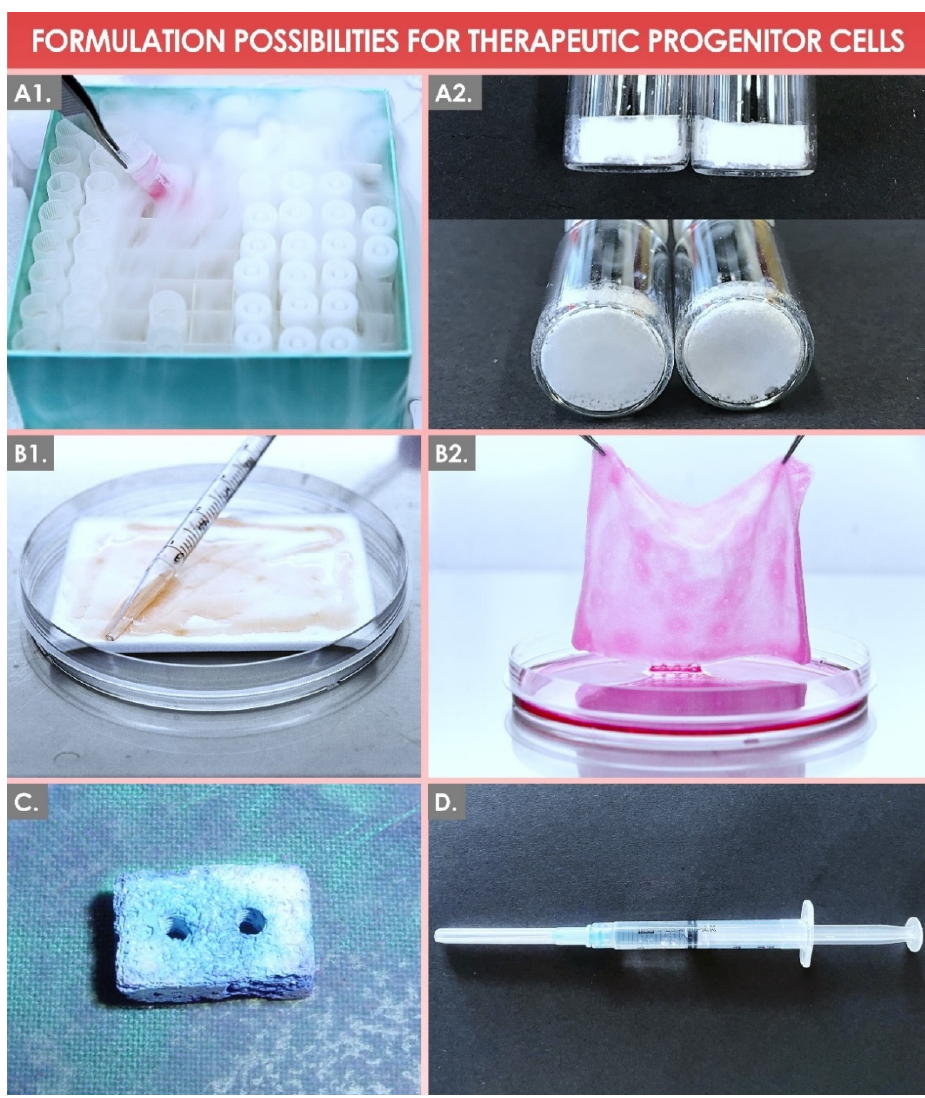
Figure 4. Graphical illustrative overview of selected formulation possibilities for therapeutic primary-progenitor cells in regenerative medicine. ( A1 ) Final form of a cellular API stored as viable cell units in liquid nitrogen. ( A2 ) Final form of a cellular API stored as devitalized cells in lyophilizate units at refrigerated temperatures. ( B1 , B2 ) Final product form of a PBB early-wound-coverage solution, composed of viable dermal progenitor fibroblasts (e.g., FE002-SK2 cell type) extemporaneously reconstituted on a collagen sheet scaffold, represented before and after overnight in vitro incubation, respectively. ( C ) Polymer-based solid tissue construct seeded with cultured primary bone progenitor cells (e.g., FE002-Bone cell type). ( D ) Hyaluronic-acid-based injectable hydrogel product loaded with cultured primary progenitor tenocytes (e.g., FE002-Ten cell type). API, active pharmaceutical ingredient; PBB, progenitor biological bandage.